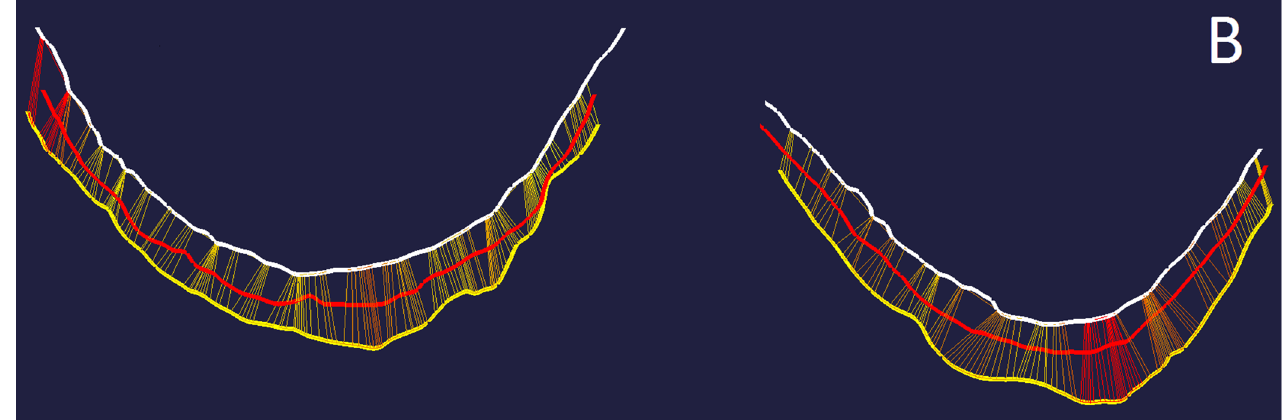
Figure 4. ( A ) Difference between base curve (white) and reference sulcus (RefS) curve (red) on both premolars (datasets of premolars hidden), resulting in the absolute sulcus depth without any gingival displacement. ( B ) Difference between base curve (white) and intervention sulcus (IntS) curve (yellow) on both premolars (datasets of premolars hidden), resulting in the absolute sulcus depth after gingival displacement by cord or paste.